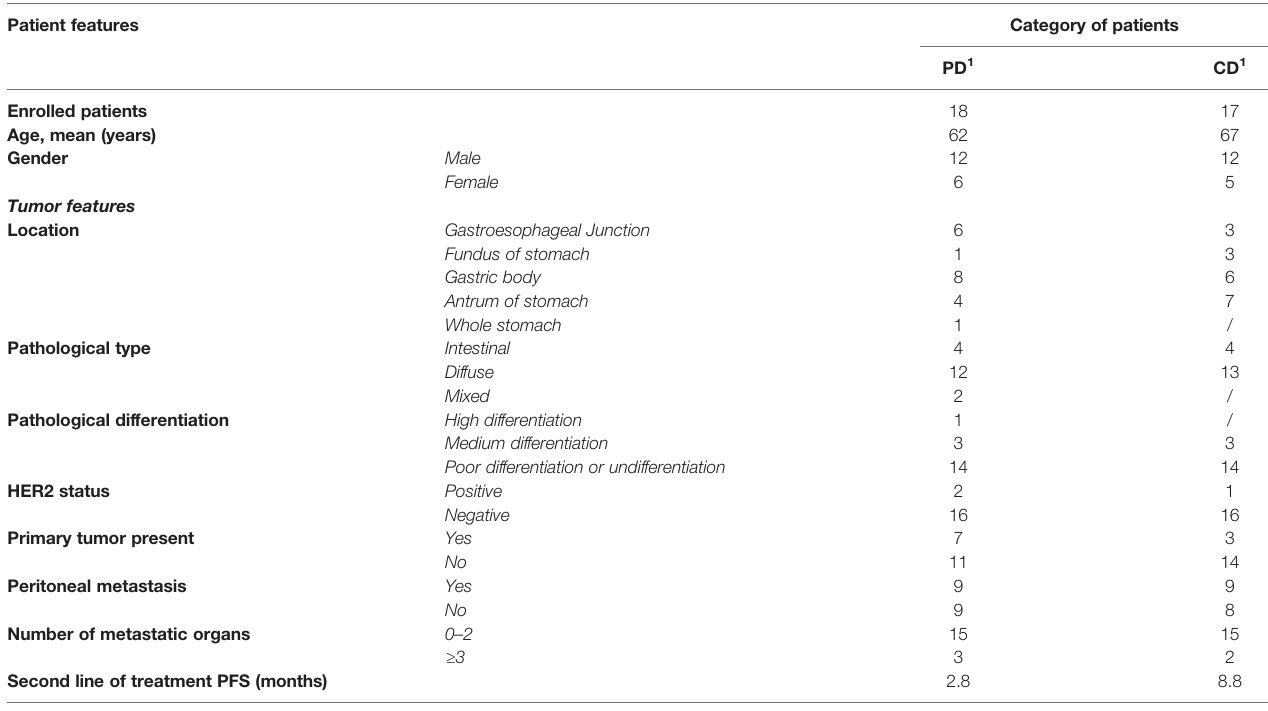
TABLE 1 | Clinicopathological features of enrolled patients (n =